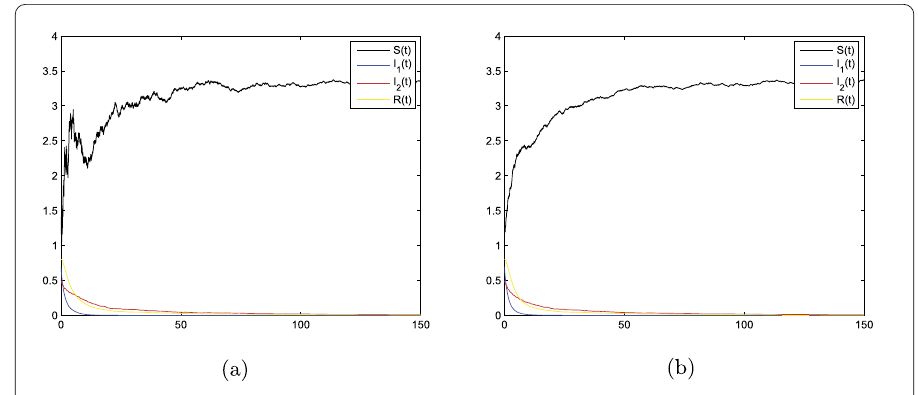
Figure 1 The trajectory of stochastic SIRS model (2) with parameters in Example 3 and the initial value S (0) = 1.2, I 1 (0) = 0.7, I 2 (0) = 0.5, R (0) =